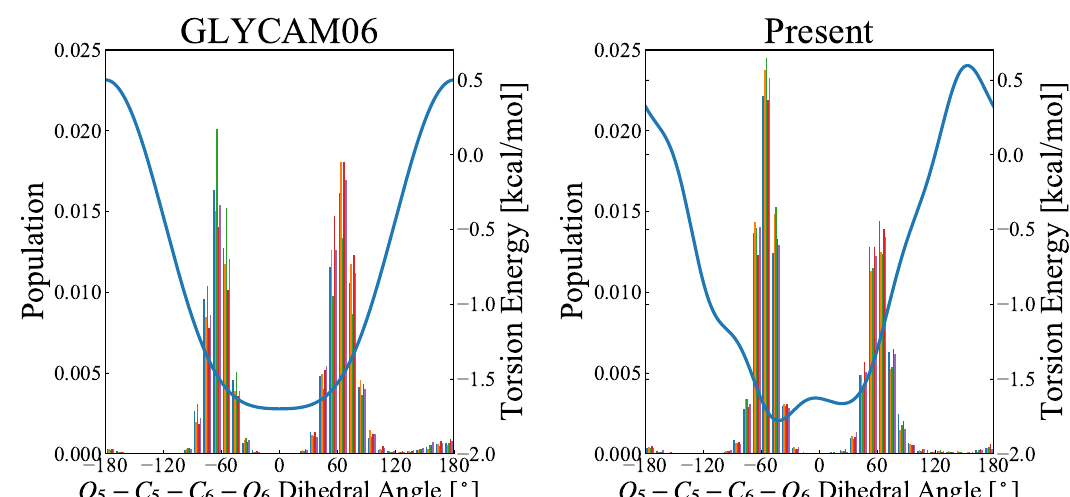
Figure 5. Distribution of O 5 – C 5 – C 6 – O 6 rotamers by MD simulations. The abscissa refers to the dihedral angle ranging from − 180 ◦ to 180 ◦ , and the ordinate is the probability density function calculated over 5000 snapshots. The left and right figures, respectively, show the results for the GLYCAM06 force field and the force field proposed herein as the molecular force field for the MD simulations. The MD calculations were performed for 50-ns-long product runs in five replicates (represented by colors), and the rotamer distribution was calculated from each of the 5000 snapshots. The fractions of gg, gt, and tg were, respectively, 45.4%, 51.7%, and 2.8% for the GLYCAM06 force field, and 58.0%, 40.5%, and 1.6% for the force field proposed herein. The blue curve in each figure represents the potential energy of torsional motion ( O 5 – C 5 – C 6 – O 6 ) associated with a change in the dihedral angle of O 5 – C 5 – C 6 – O 6 .